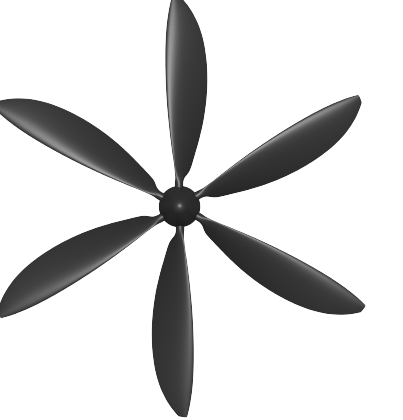
Figure 8. Top view of the optimised propeller geometry under hovering conditions.